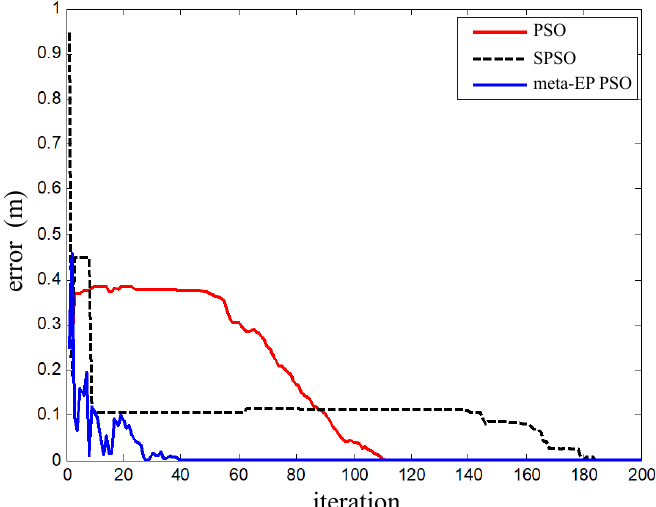
Figure 7. The locating error of one of the conducted